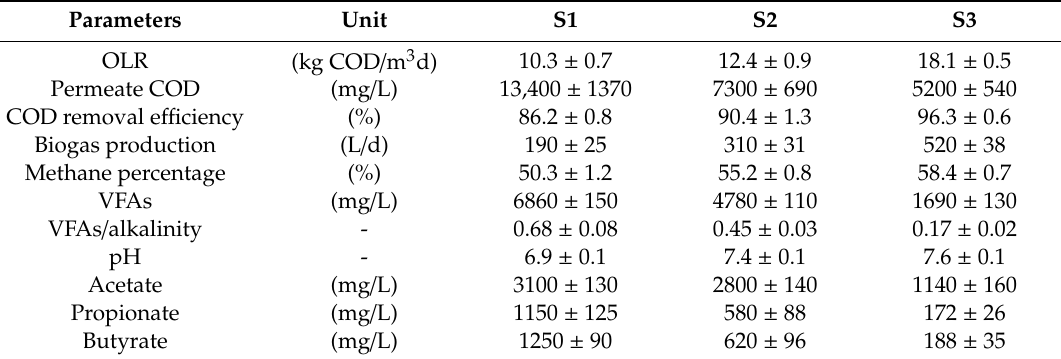
Table 1. Performance of the AnMBR at di ff erent sludge cycle frequencies (mean ± standard deviation).